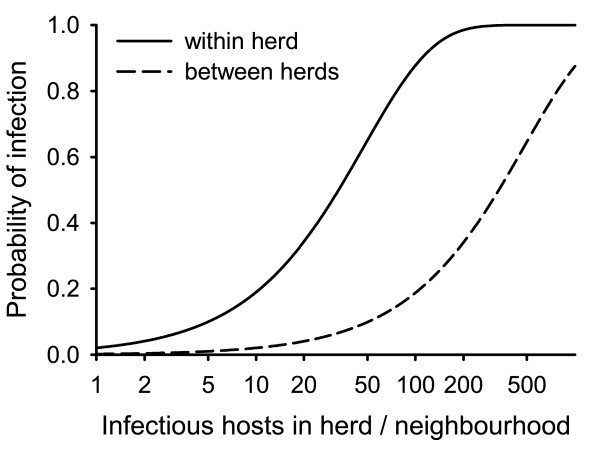
Probability of infection, depending on the number of infectious hosts in the herd (solid, Pinf(i)=2.08⋅10-2) and in neighbouring herds (dashed, Pinf(e)=2.08⋅10-3).